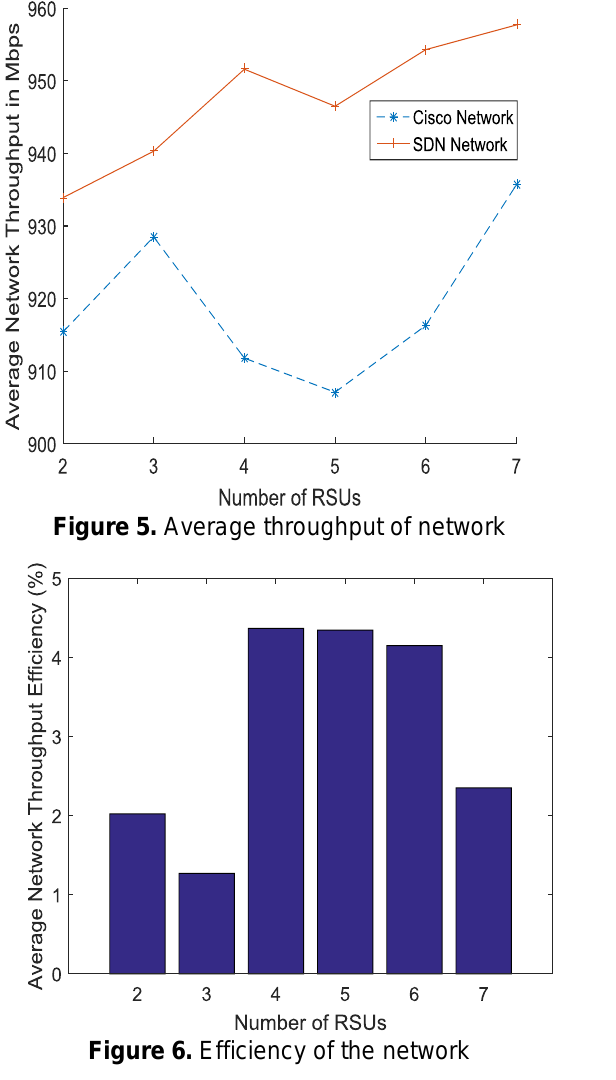
Figure 6. Efficiency of the